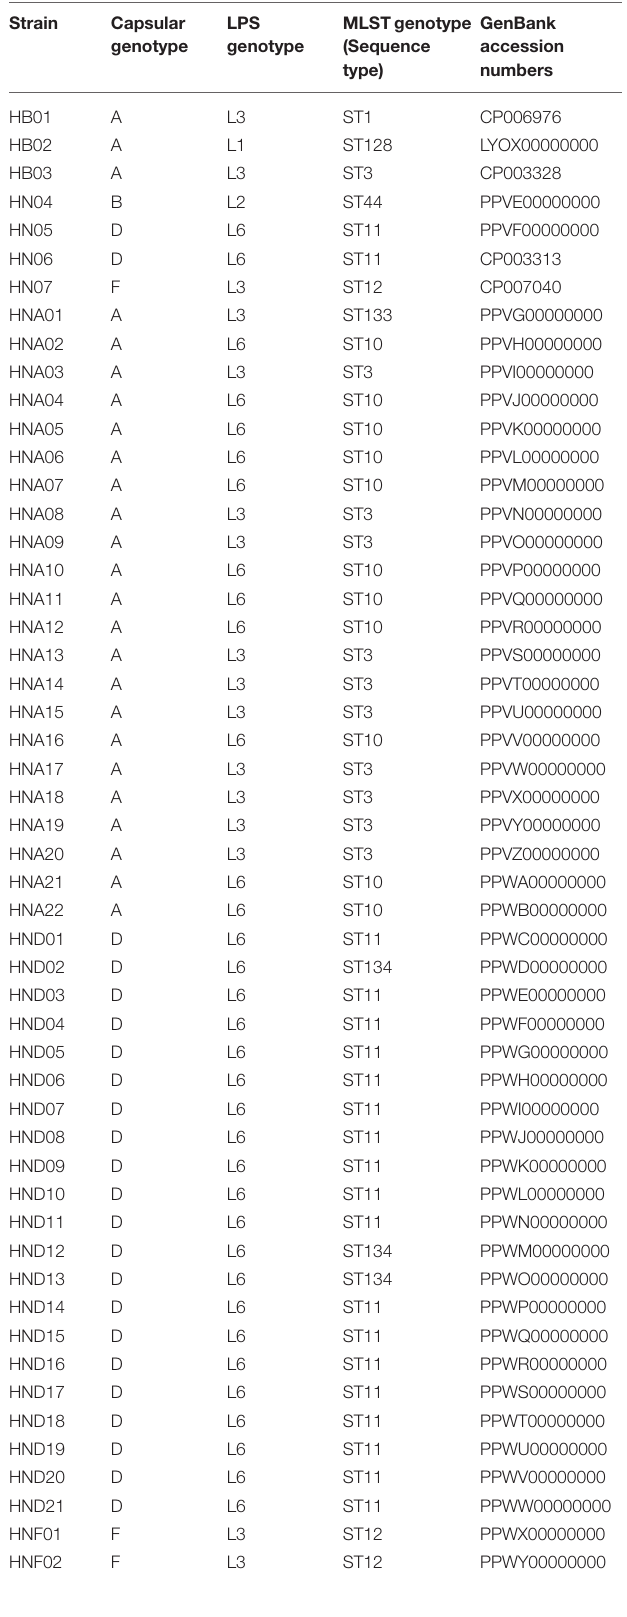
TABLE 1 | Genotypes of 52 Pasteurella multocida strains determined via the PmGT Platform. Strain Capsular